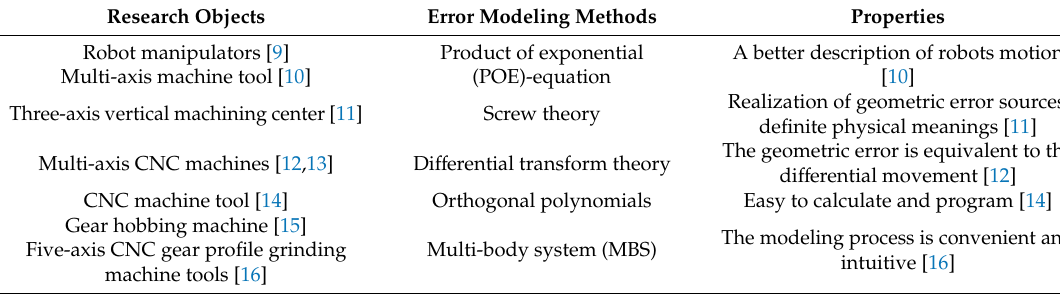
Table 1. Published applications of error modeling